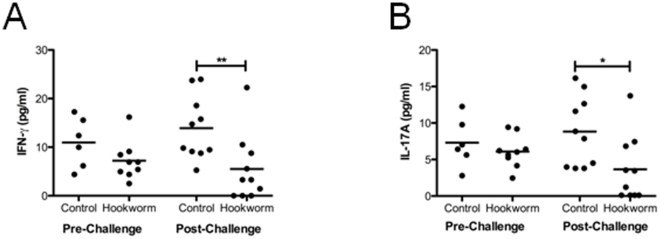
Biopsies taken pre-challenge (week 20) and post-challenge (week 21) from trial 1 and were cultured for 24 hours in tissue culture medium, then supernatants taken for CBA analysis of IFN-γ (A) and IL-17A (B).One-way ANOVA was carried out comparing between groups and timepoints. Unless otherwise indicated differences are not significant. ** = p<0.01, * = p<0.05.